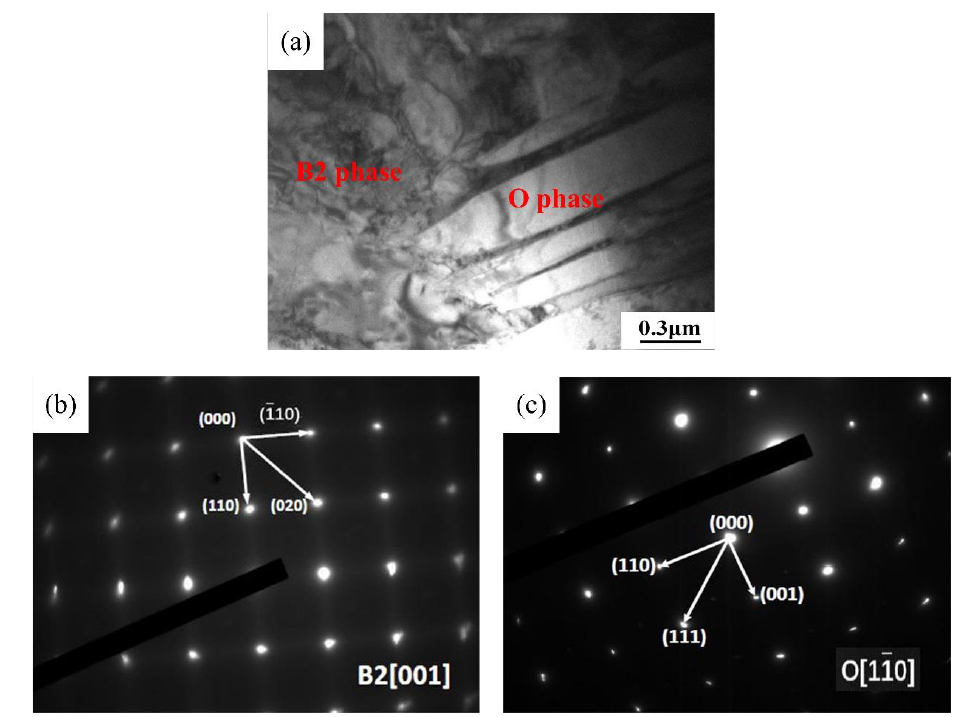
Figure 8. TEM results of a weld zone with Nb filler metal: ( a ) bright field image; ( b ) selected area diffraction pattern of B2 phase and ( c ) selected area diffraction pattern of O phase.